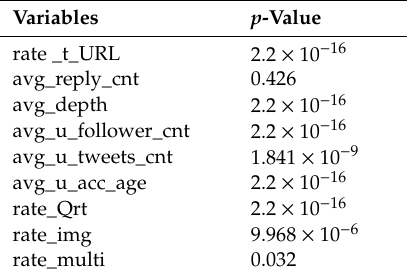
Table 4. The t -test results of features. Table 5. The t -test results of features.